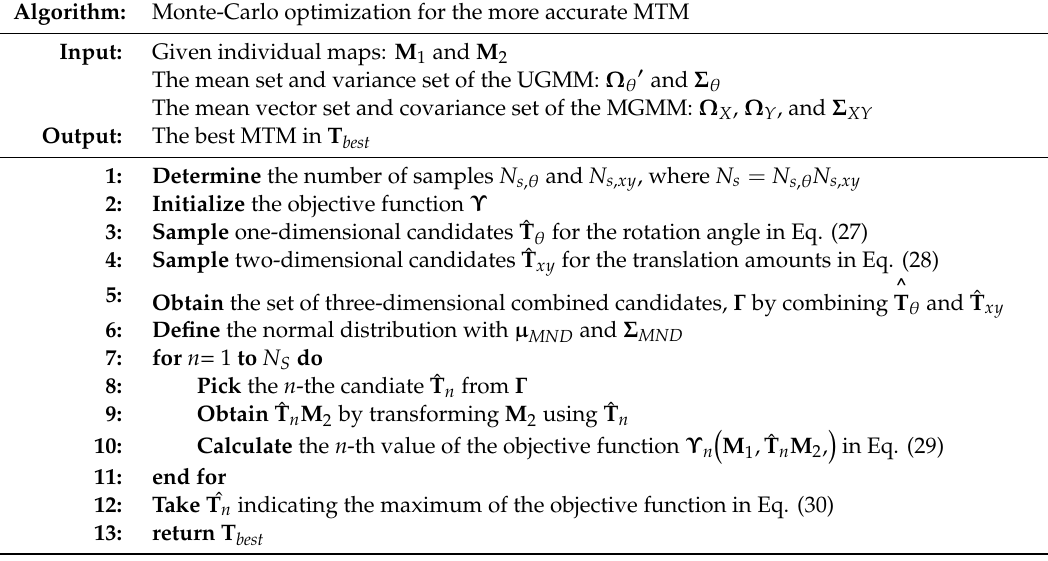
Table 1. Optimization to acquire the more accurate MTM (map transformation